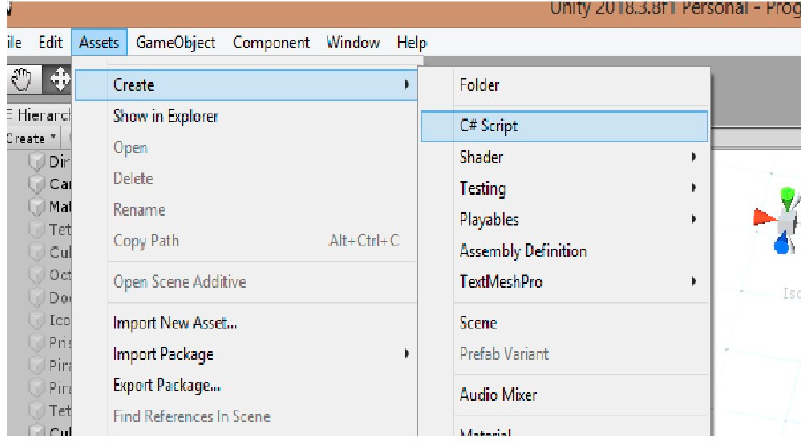
Figure 1. Creating a script in Unity.